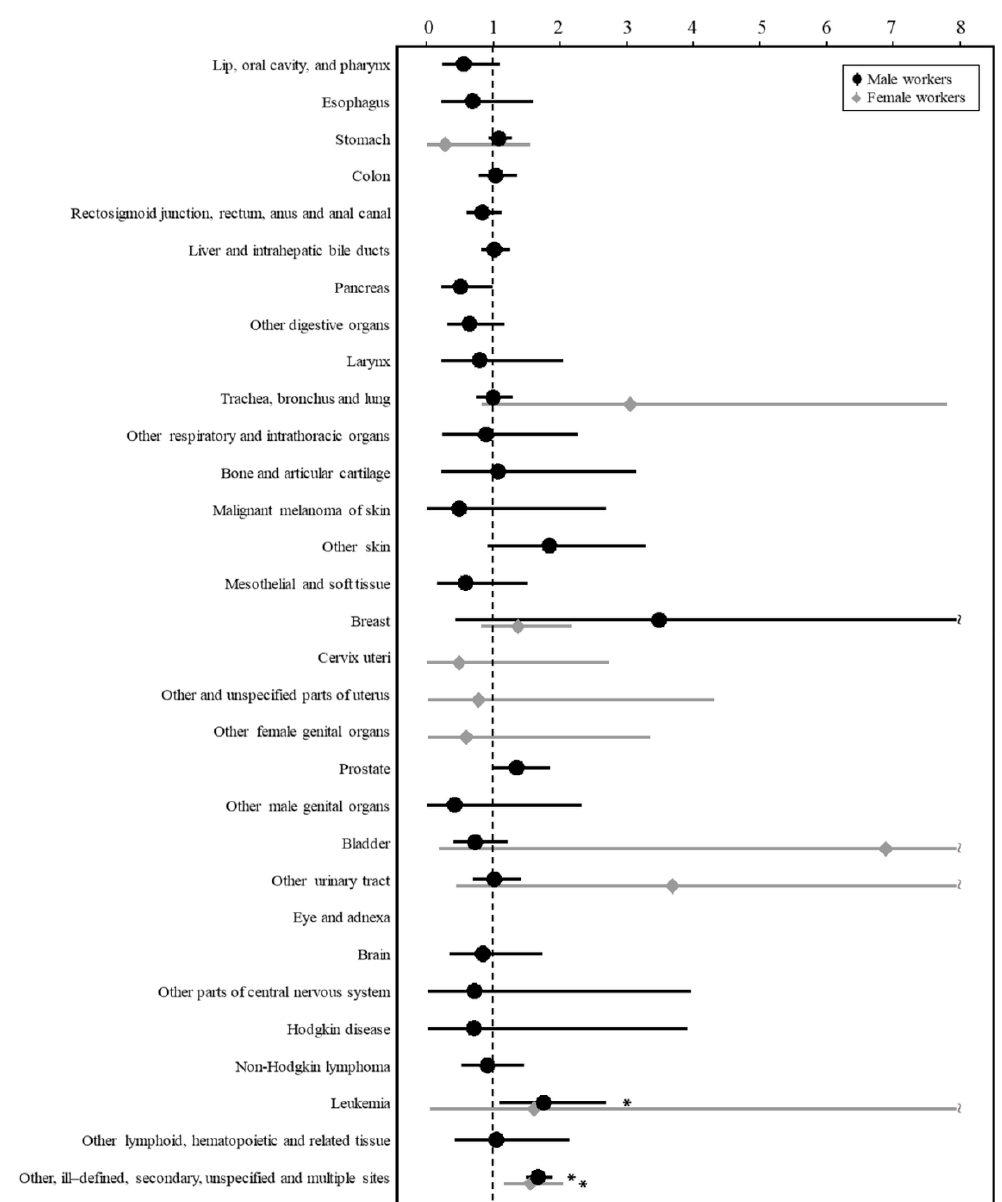
Figure 2. Age-standardized incidence rate (95% confidence interval) of cancers referenced with whole employee.